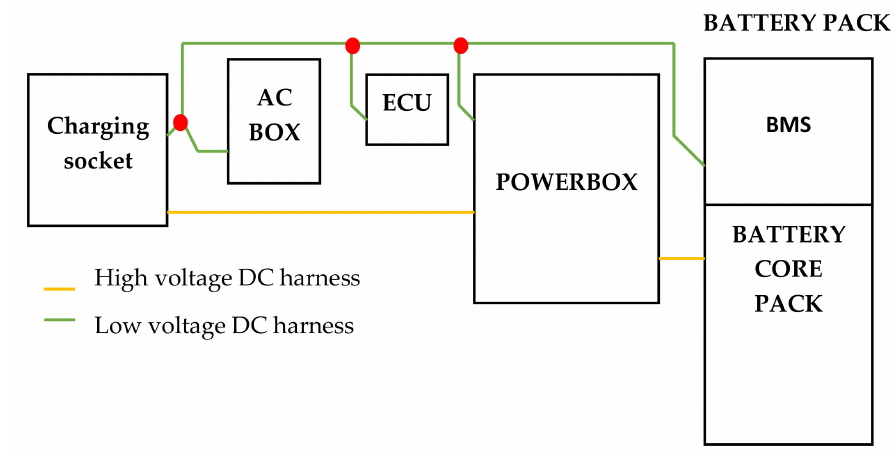
Figure 4. Overall scheme of the Type 4 charging system.